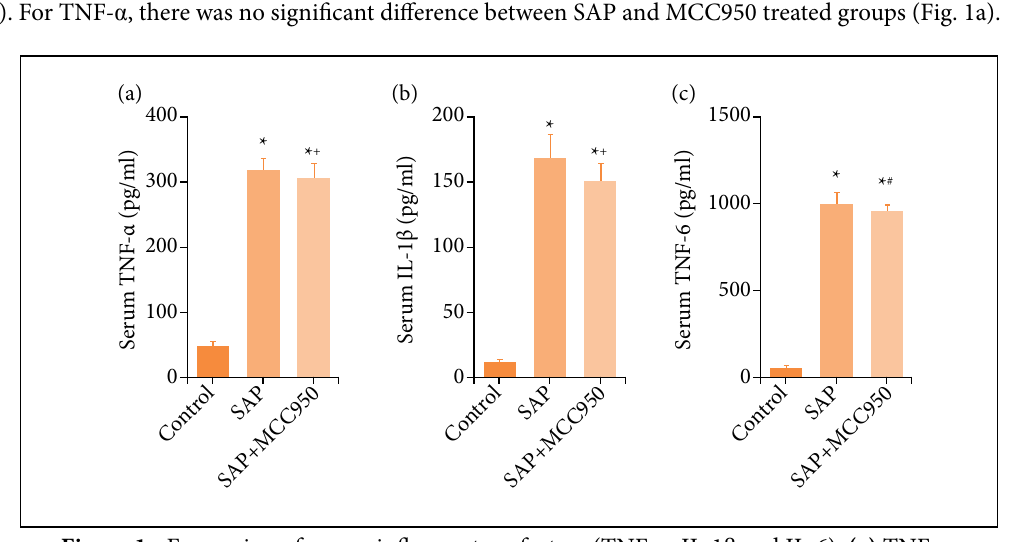
Figure 1 - Expression of serum inflammatory factors (TNF- α , IL-1 β and IL-6); (a) TNF- α ; (b) IL- β ; (c) IL-6. N = 6; * p < 0.001 vs. control; + p < 0.05 vs. SAP; # p < 0.01 vs. SAP.